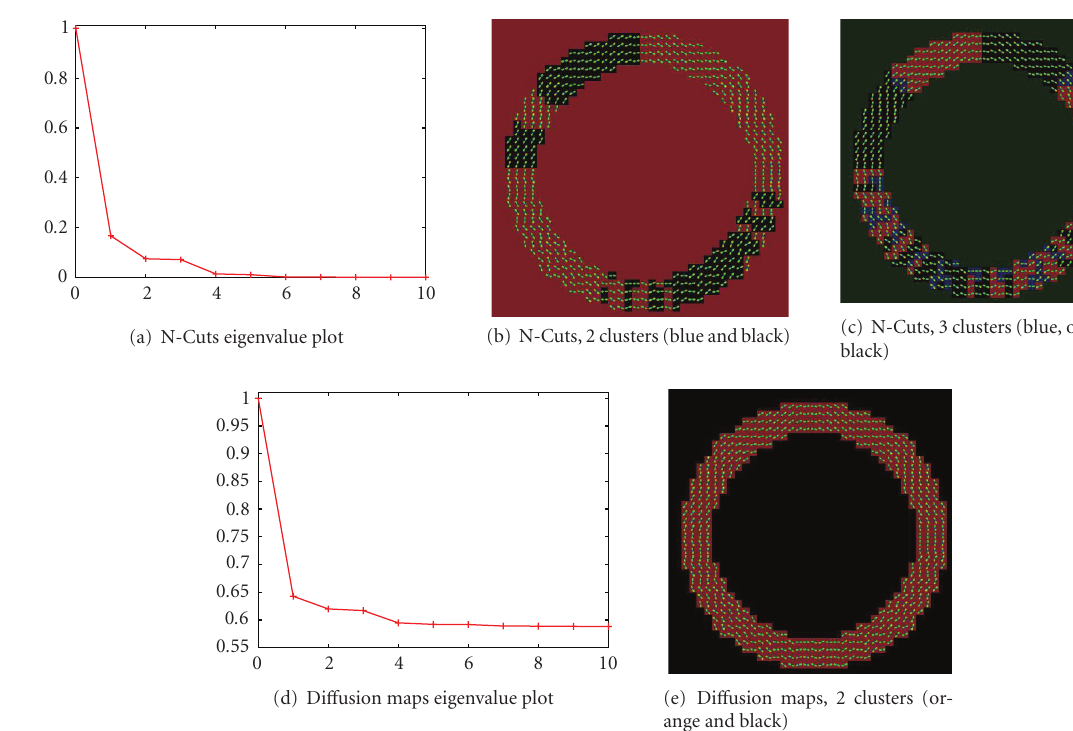
Figure 2: N-Cuts generates overclustering due to sampling frequency variation in ODF images. In both eigenvalue plots Figures 2(a) and 2(d), the slope between the line joining λ 0 and λ 1 and the line joining λ 1 and λ 2 changes drastically, expressing an elbow in λ 1 , which indicates two clusters. The clustering results with Figures 2, 2(b), 3, 2(c), clusters are shown. Di ff usion maps correctly finds two clusters, the object and the background, Figure 2(e). In the labeling, the ODFs are overlaid on the labels.